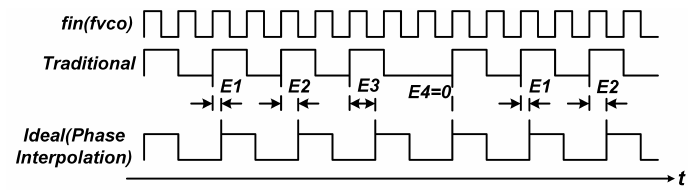
Figure 1. The idea of phase interpolation.